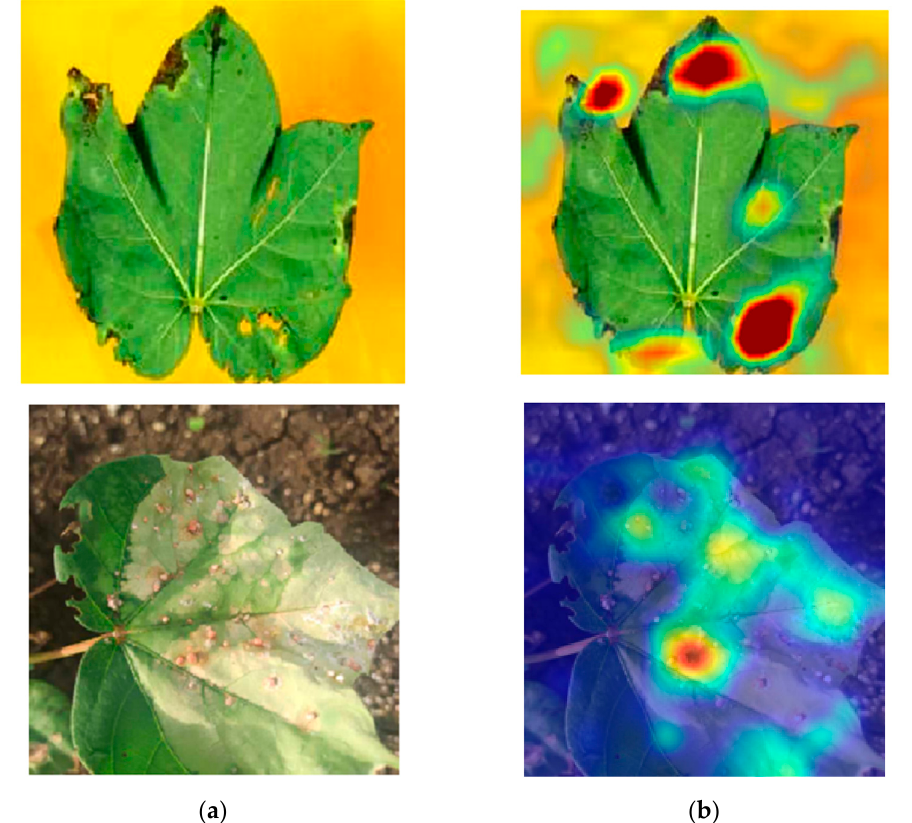
Figure 6. True-positive classification. ( a ) Input image. ( b ) Heatmap scores. The false-positive images are without infection, but the model classifies them as an infection. The false-positive and negative images are visualized using the network, as shown in Figures 7 and 8.